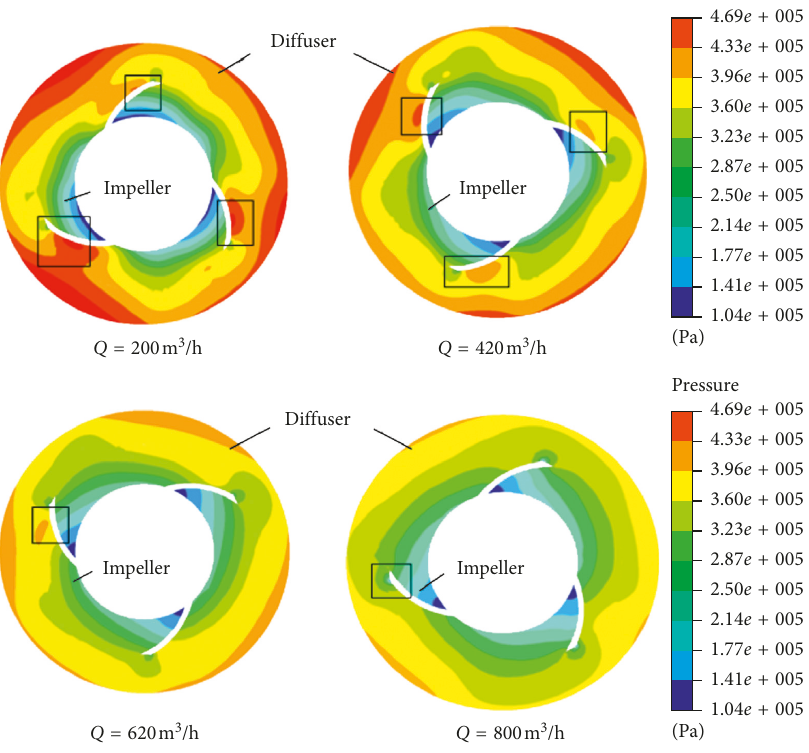
Figure 14: Static pressure distribution at Z � 170mm for different flow rates.